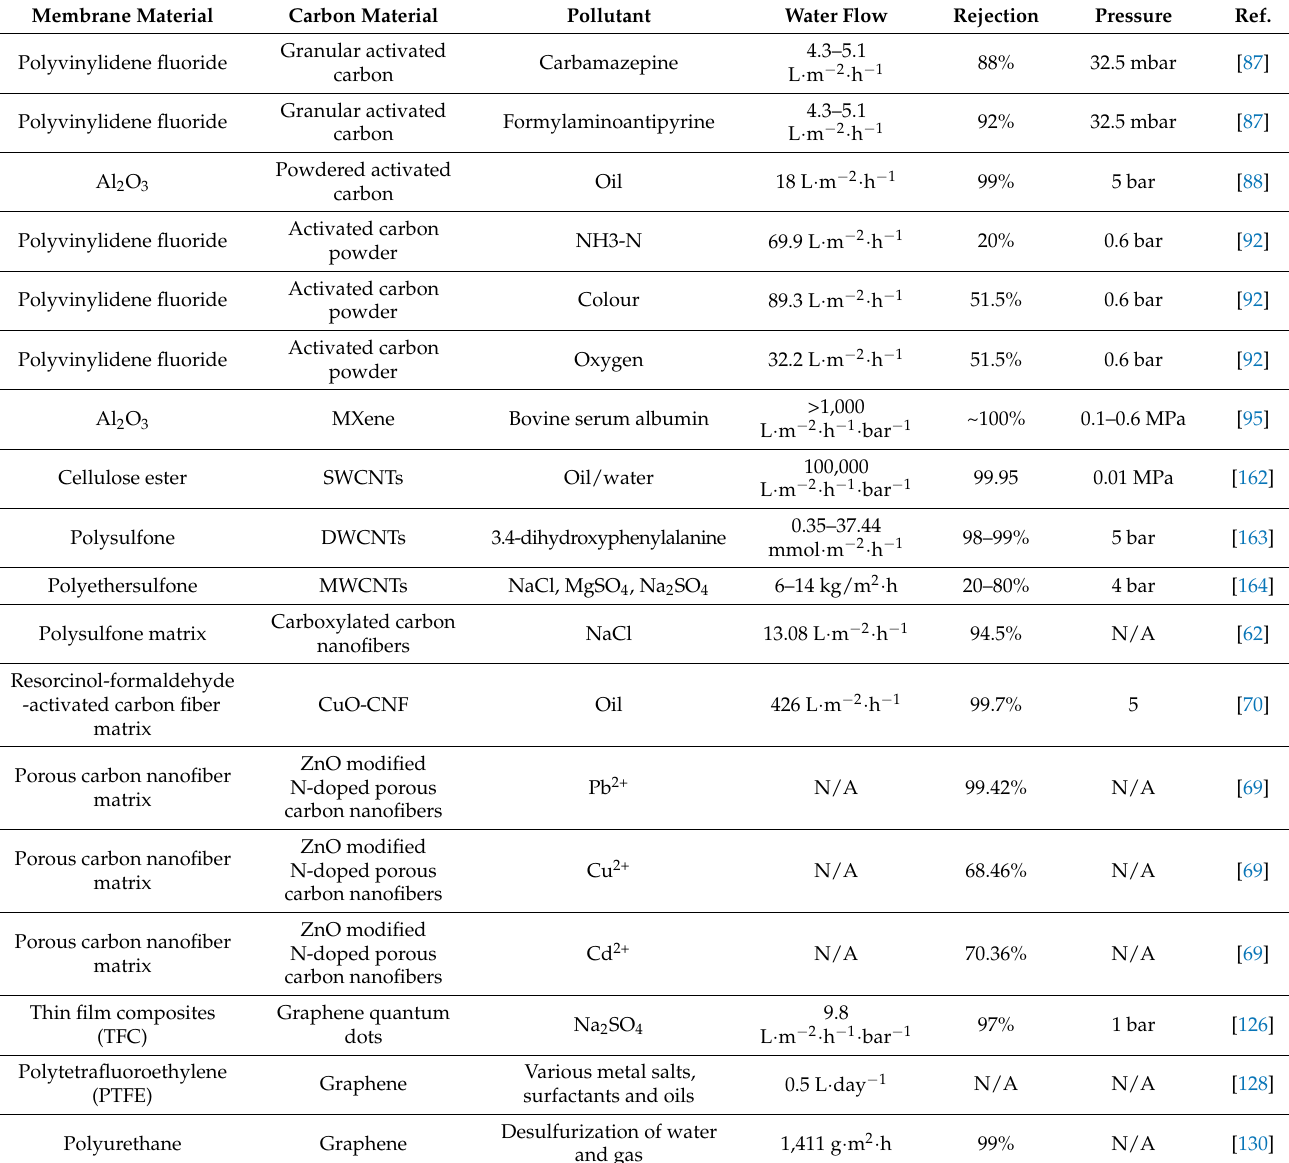
Table 1. Application of carbon nanomaterials and related materials in